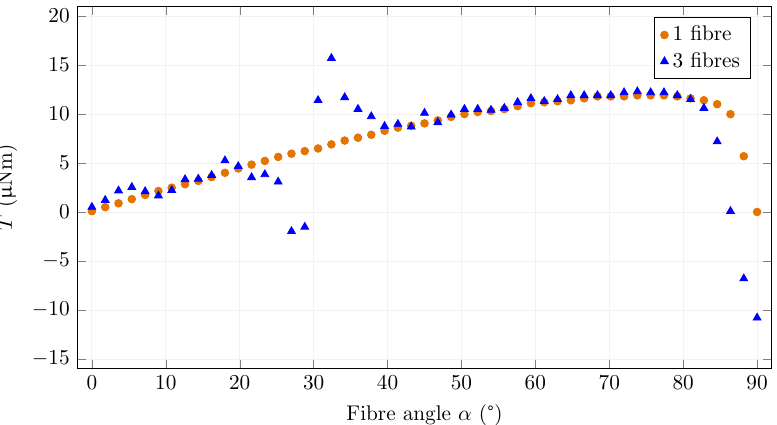
Figure 14. Torque and fibre angle relationship for one and three fibres for B 0 = 25